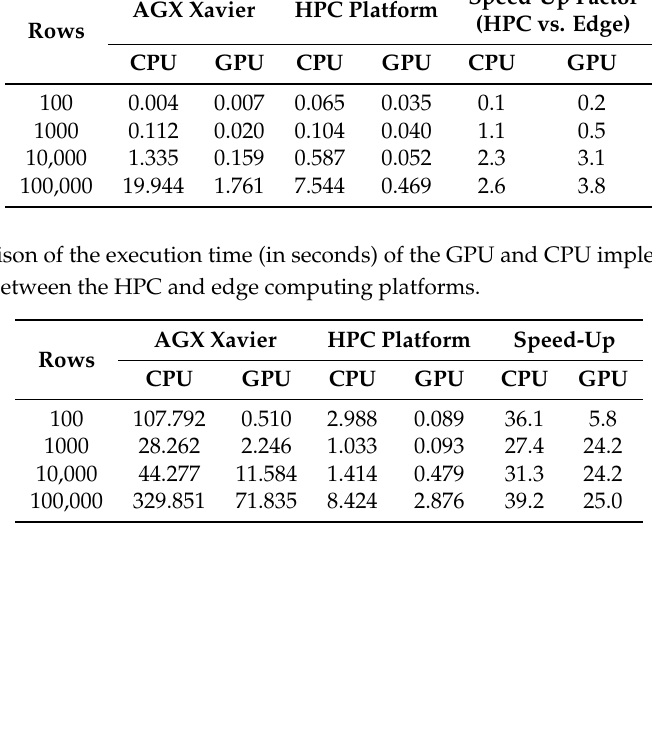
Table 2. Comparison of the execution time (in seconds) of the GPU and CPU implementations of the k-means algorithm between the HPC and edge computing platforms. AGX Xavier HPC Platform Rows